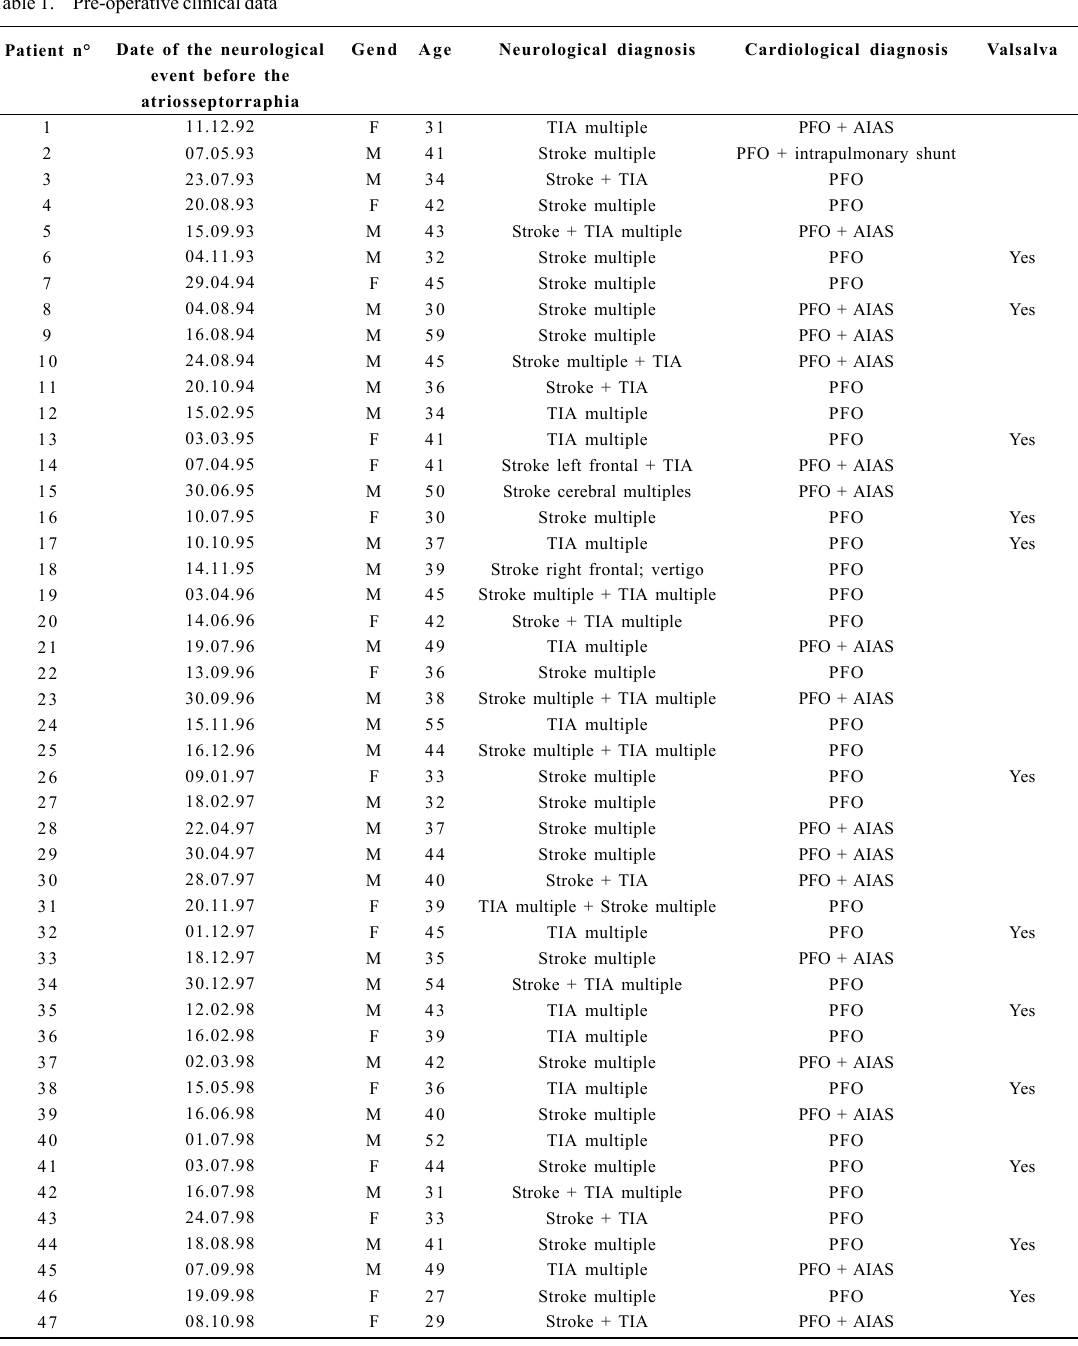
Table 1. Pre-operative clinical